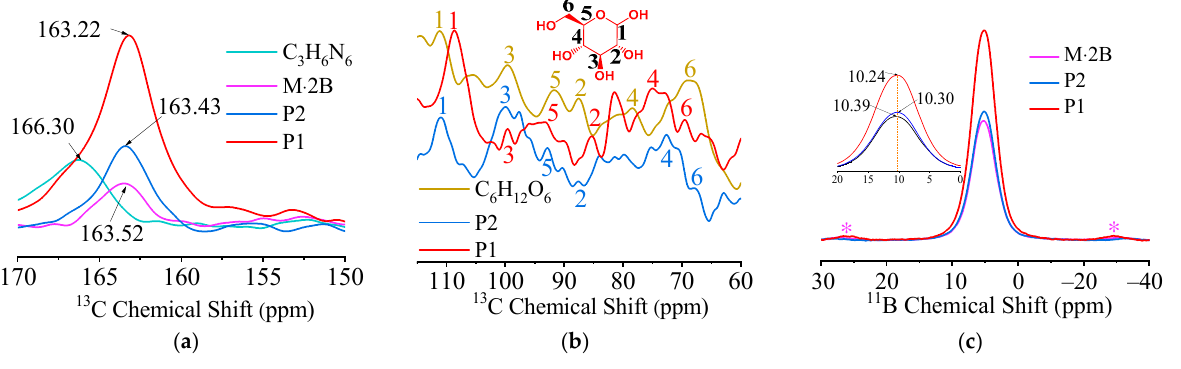
Figure 2. ( a , b ) 13 C Solid-state MAS NMR spectra of M · 2B, P1, and P2. Arabic numerals in inset of ( b ) represent the location of carbon of glucose. ( c ) 11 B Solid-state MAS NMR spectra, * denotes spinning side band.